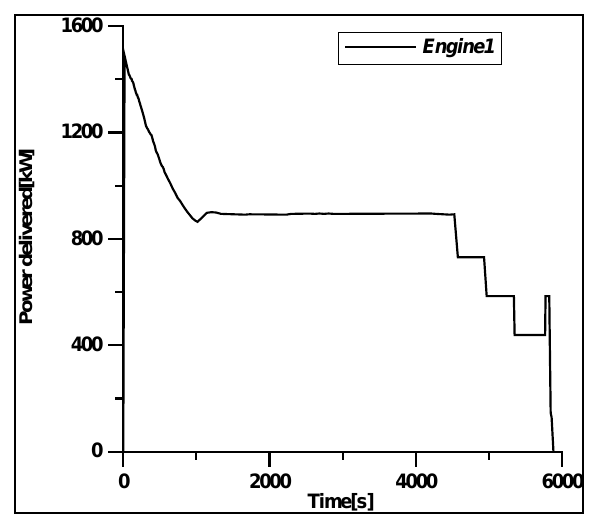
Figure 11. Power delivered during the flight mission.